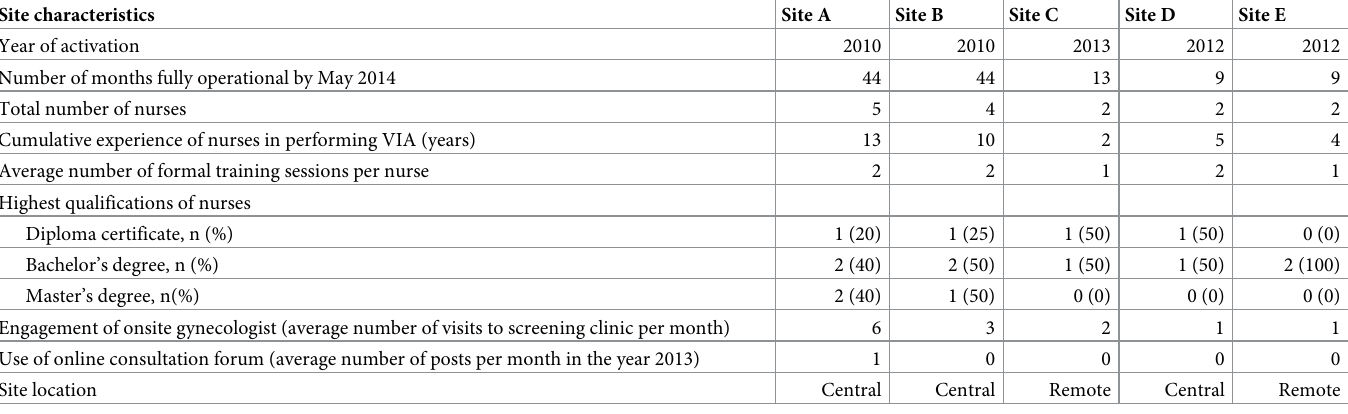
Table 1. Characteristics of VIA screening